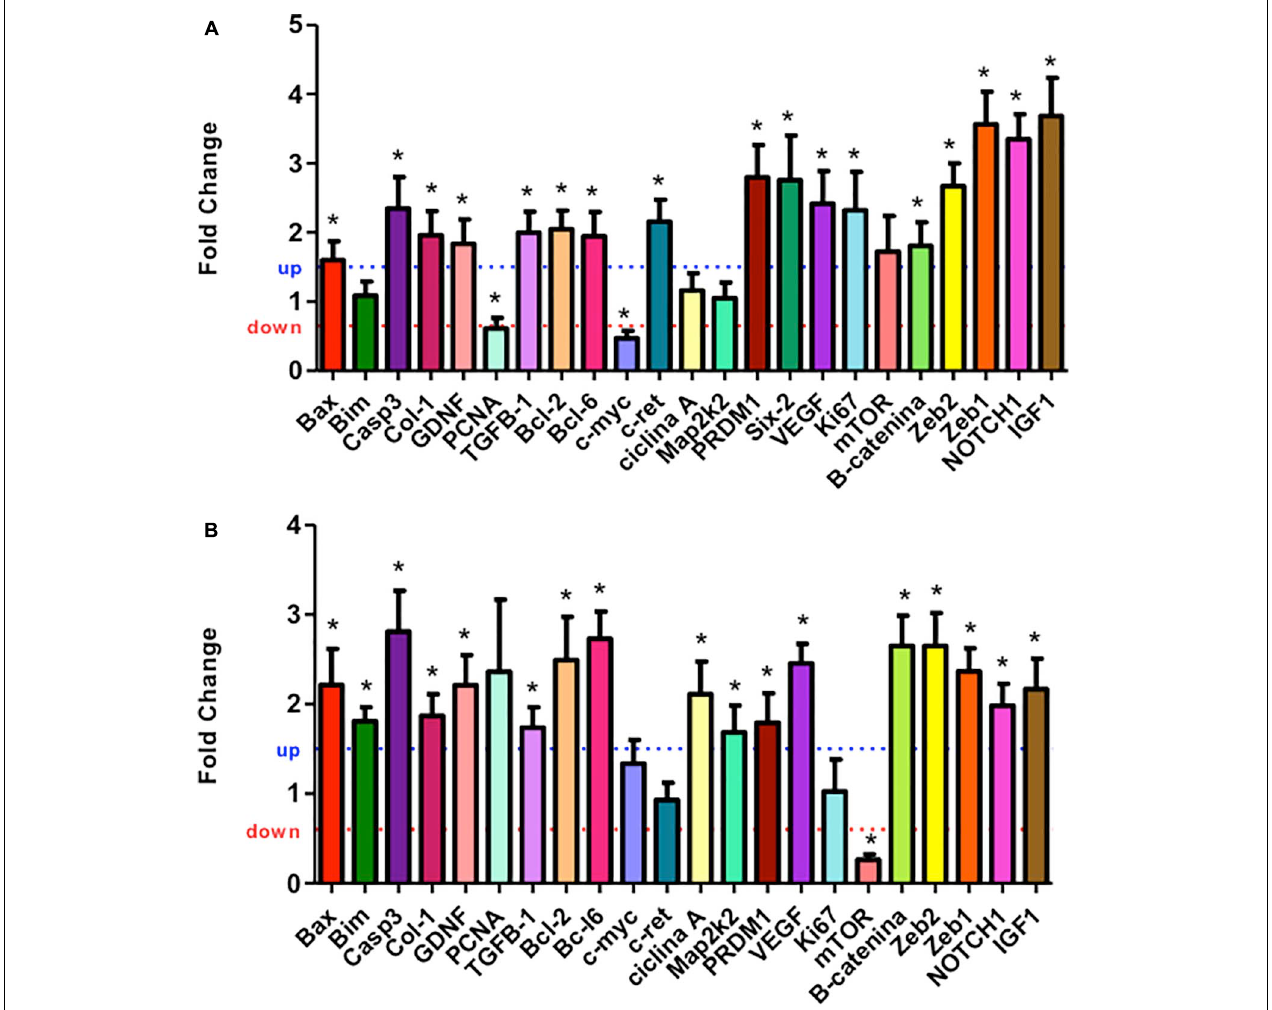
FIGURE 4 | Renal expression estimated by SyBR green RT-qPCR of mRNA from 21GD (A) to 7DL (B) LP rats. The expression was normalized with GAPDH. The authors established a cutoff point variation of 1.3 (upwards) or 0.65 (downwards), and data are expressed as fold change (mean ± SD, n = 4) concerning the control group. * p ≤ 0.05: statistical significance versus